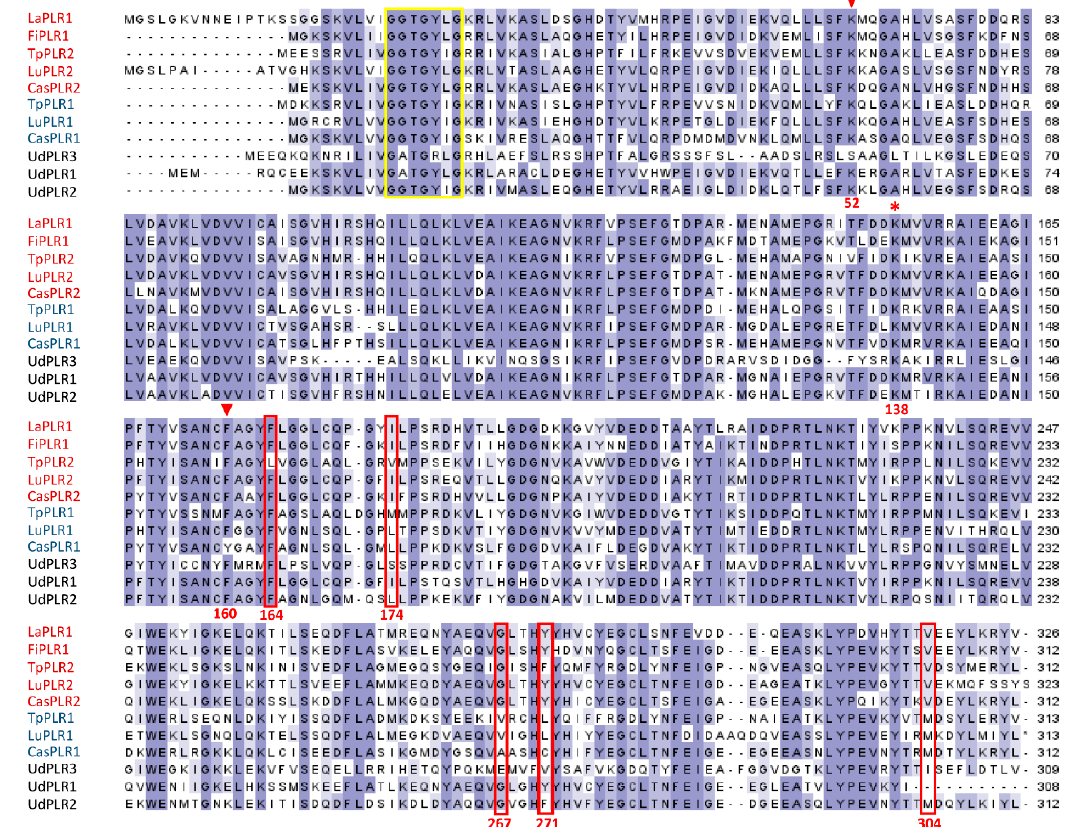
Figure 4. Multiple sequence alignment of UdPLRs and functionally characterised plant PLR proteins.